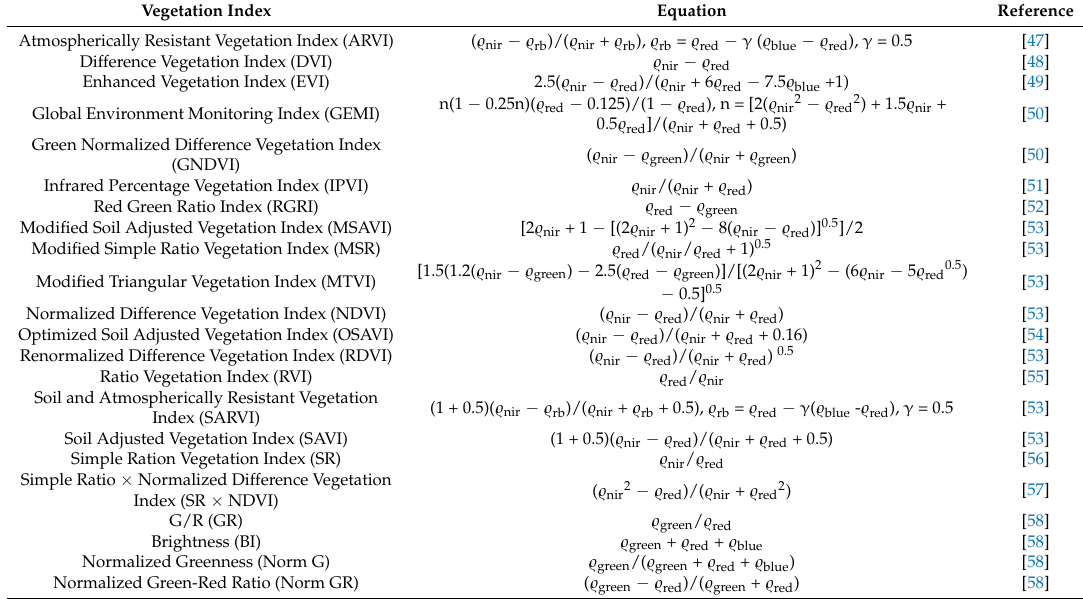
Note: The vegetation indices were calculated using raw imagery bands; (cid:36) blue = Blue band, (cid:36) green = Green band, (cid:36) red = Red band, (cid:36) nir = Near infrared